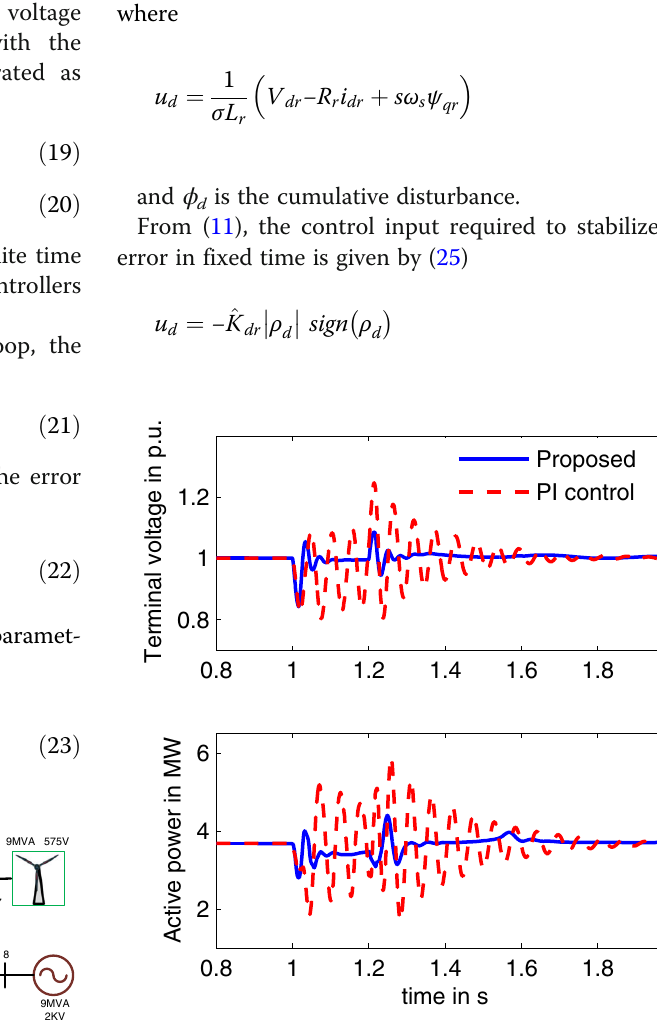
Fig. 6 Terminal voltage and active power deviations for a three-phase fault at bus